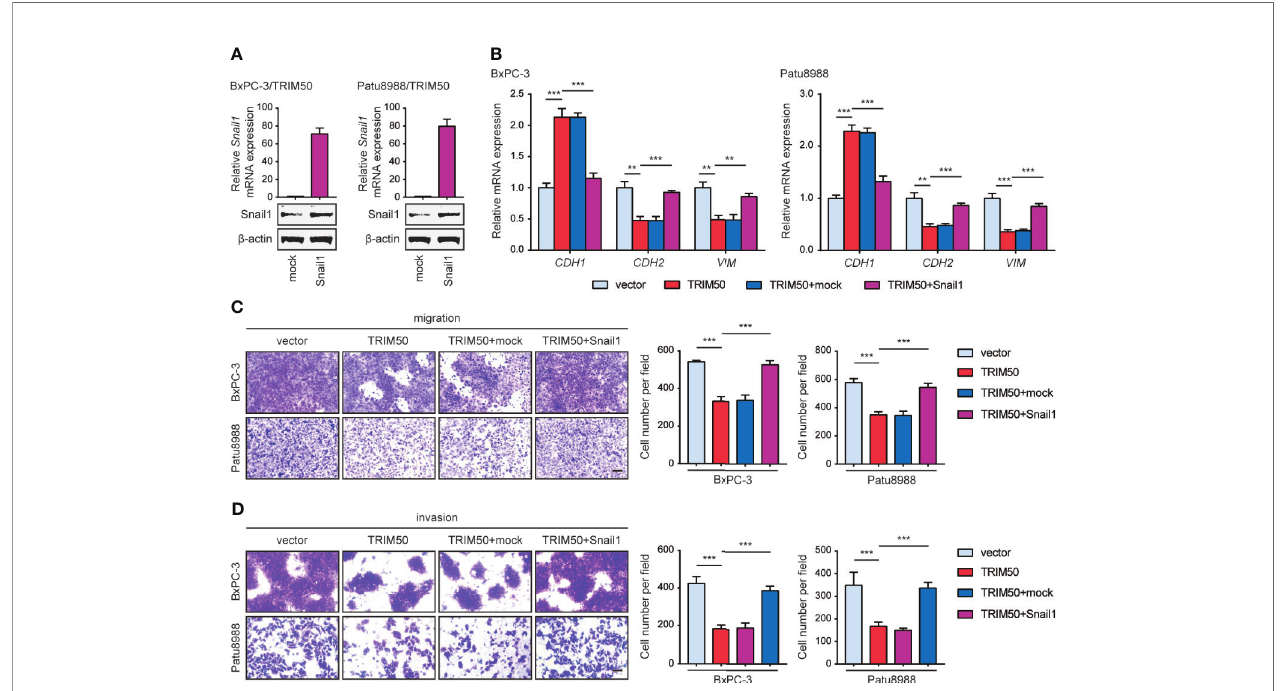
FIGURE 6 | Snail1 is responsible for the effects of TRIM50 on cell migration, invasion, and EMT. (A) TRIM50-overexpressing BxPC-3 and Patu8988 cells were transfected with Snail1 and vector pcDNA3.1(+) (termed as mock) plasmids. The ef fi ciency of Snail1 expression was con fi rmed by qRT-PCR (upper panel) and western blotting (lower panel). (B) Re-expression of Snail1 largely or completely abrogated the inhibiting effects of TRIM50 on EMT by examining the expression of EMT-related markers at mRNA level. (C, D) Re-expression of Snail1 largely or completely abrogated the inhibiting effects of TRIM50 on cell migration (C) and cell invasion (D) revealed by Transwell assays. Scale bar: 50 m m. ** P < 0.01 and *** P <